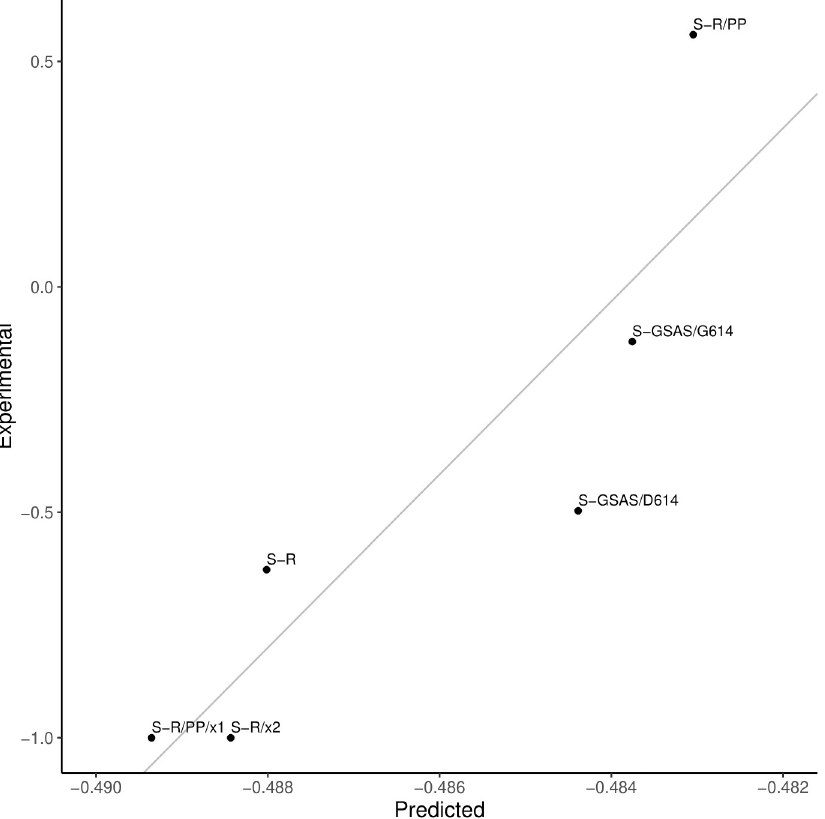
Fig 8. Difference in the occupancies for the open and the closed states (open–closed) for six variants of the Spike protein. Experimental values are represented on the Y-axis and the predicted values in the scale on the X-axis. Predicted values for the parameters k = 0.5, γ = 0.001. Represented linear fit of Experimental = 192 . 011 � Predicted + 92 . 9013 . Errors on the experimental measurements are not known.